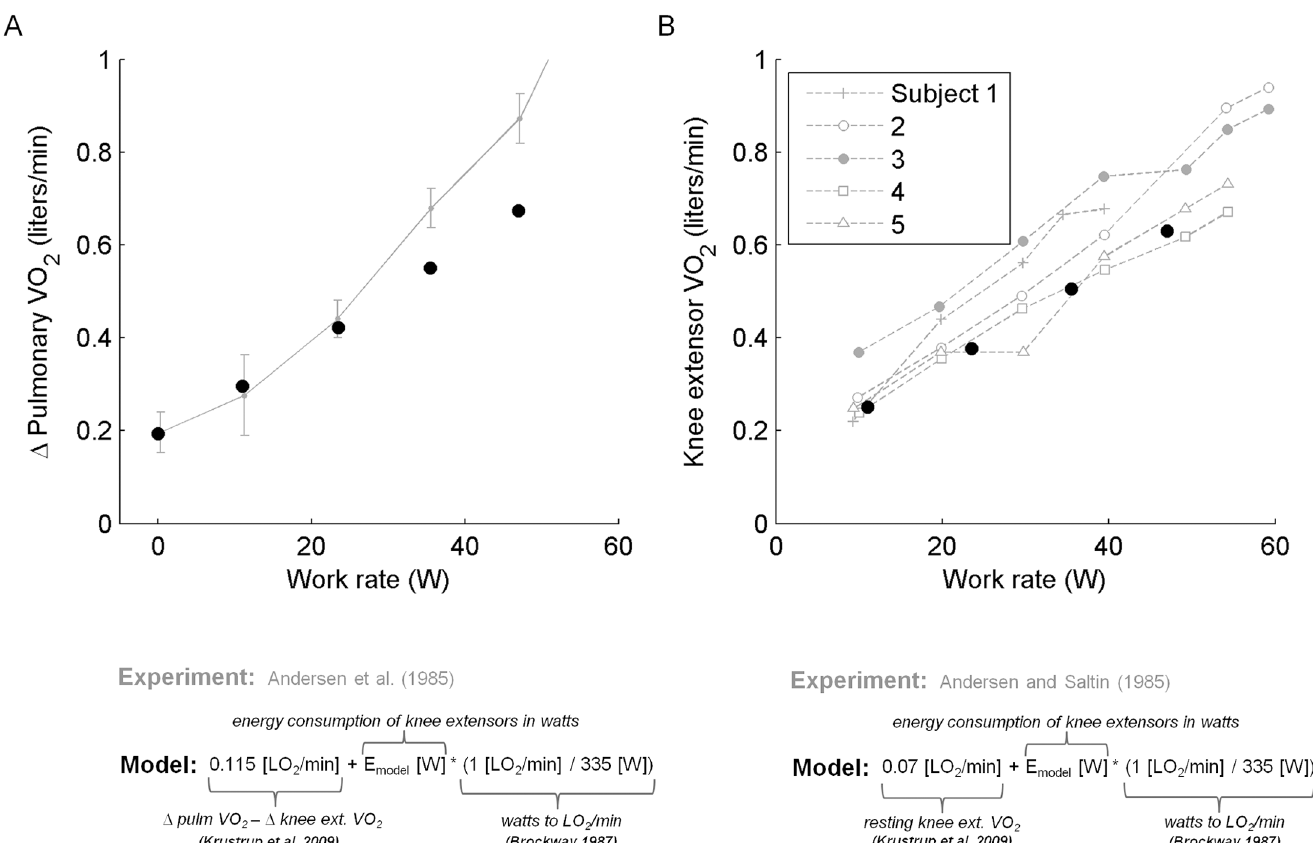
Fig 5. Validation of model predictions. A. Model predictions of energy consumption across dynamic knee extension loads is compared against the rise of pulmonary VO 2 measured experimentally for eighteen subjects [21]. Δ Pulmonary VO 2 refers to the increase in steady state rate of oxygen uptake rate by the lungs from rest to exercise. This quantity corresponds to oxygen uptake due to exercise alone (i.e., it does not include the oxygen uptake due to physiological processes contributing to basal oxygen uptake). The model predicts metabolic energy consumption of leg muscles due to exercise (in watts) so to compare it with the Δ Pulmonary VO 2 data reported, the model output of energy consumption of the leg in watts was converted to liters of oxygen uptake per minute [36] and then added to the oxygen uptake due to exercise from energy sources other than the leg ( Δ pulm VO 2 - Δ leg VO 2 ; derived from Krustrup et al. [24]). B. Model predictions are compared against oxygen uptake of the knee extensors measured for five subjects [22]. Knee extensor VO 2 refers to the steady state rate of oxygen uptake by the knee extensor muscles during exercise. This quantity includes oxygen uptake due to exercise as well as the basal oxygen uptake that is measured at rest. The model predicts metabolic energy consumption due to exercise in watts so to compare it with the knee extensor VO 2 data reported, the model output of energy consumption of the knee extensors in watts was converted to liters of oxygen uptake per minute [36] and then added to the resting level of knee extensor oxygen uptake obtained from Krustrup et al.